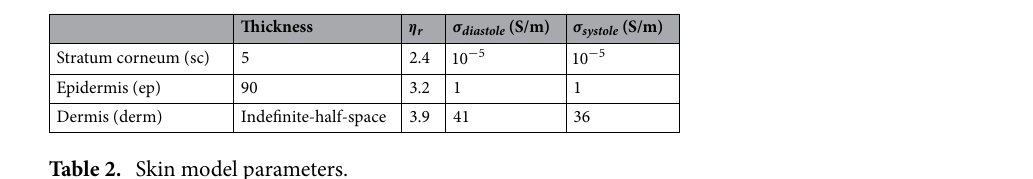
Table 2. Skin model